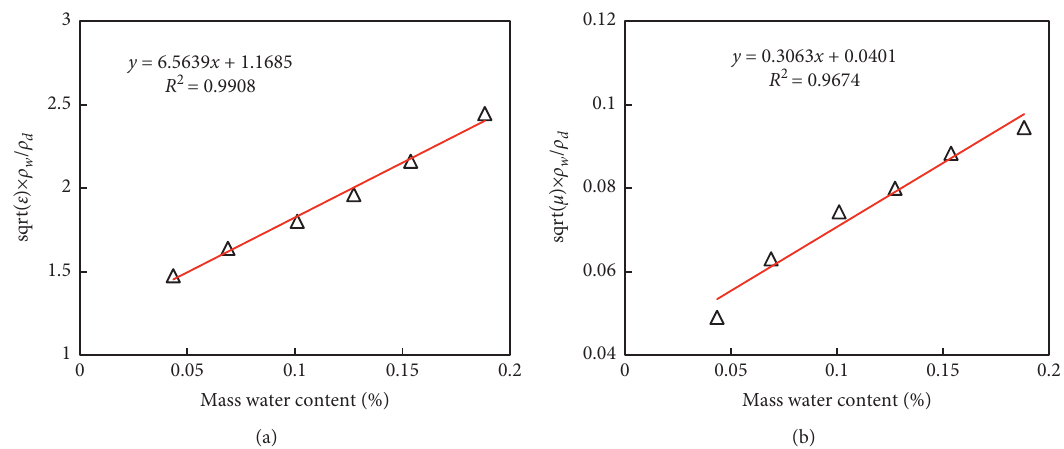
Figure 3: Calibration results of sensor parameters: (a) dielectric constant; (b) magnetic permittivity.